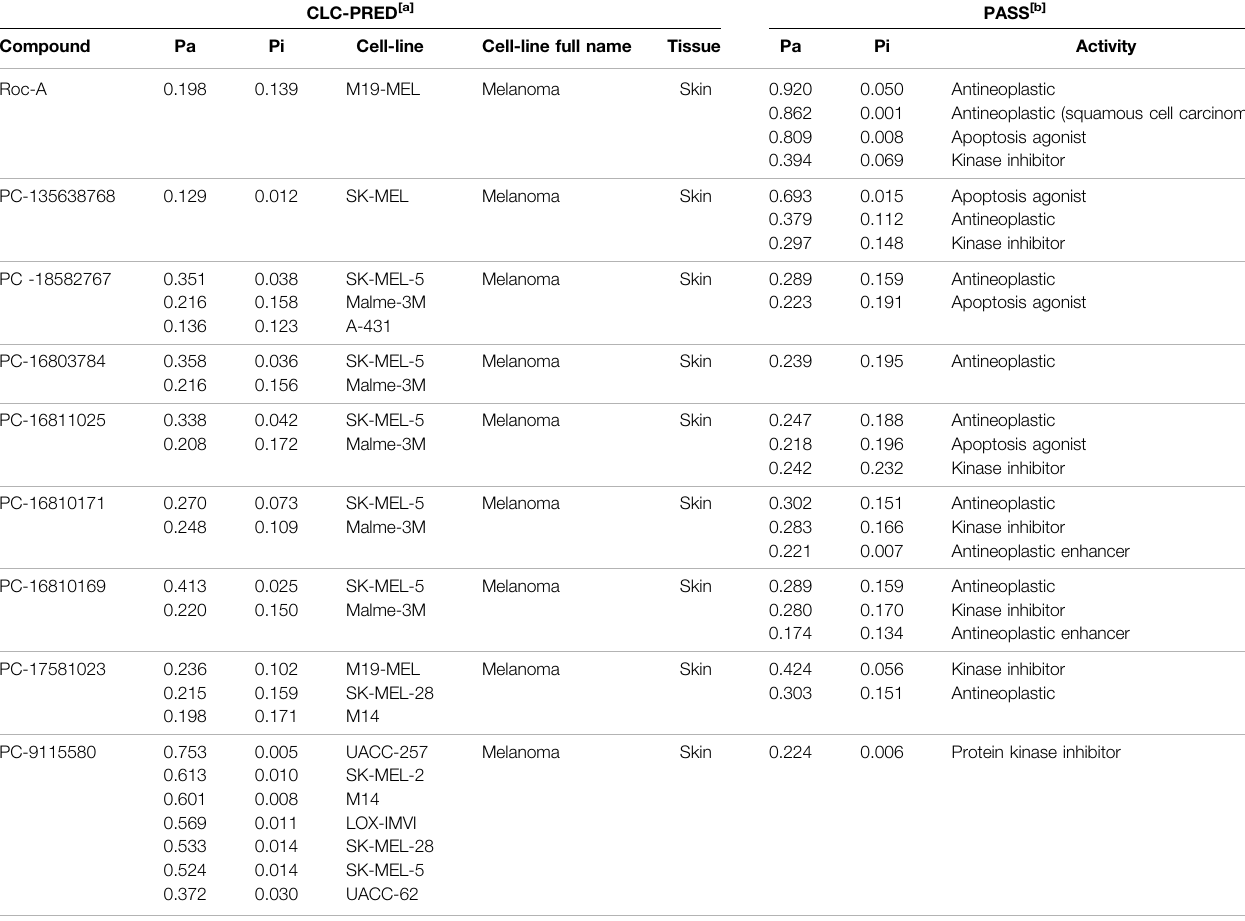
TABLE 12 | Prediction of biological activity and cytotoxic effect of promising compounds via PASS online and CLC-Pred, respectively.